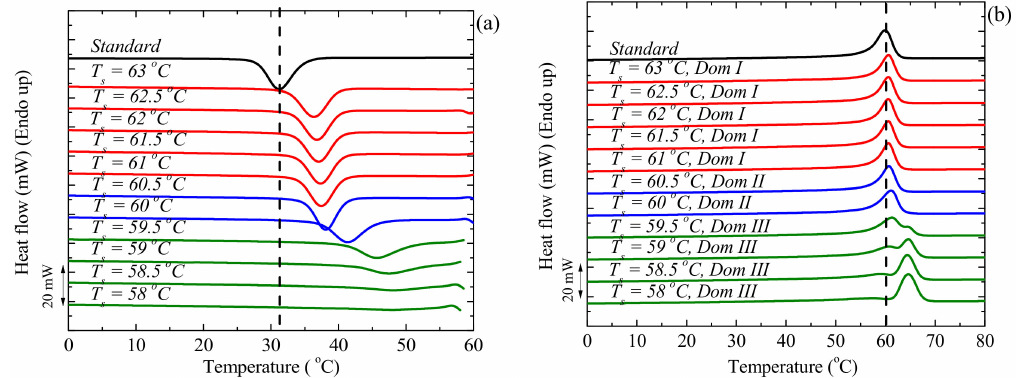
Figure 14. ( a ) DSC cooling scans for neat PCL after 5 min at the indicated T s , and ( b ) subsequent heating scans after the cooling runs shown in ( a